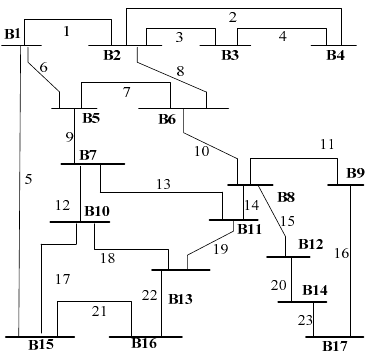
Figure 5. The IEEE39 node system’s communication network after merging bus bars in the same substation as one point, which is convenient for introducing the partition strategy proposed in this article.